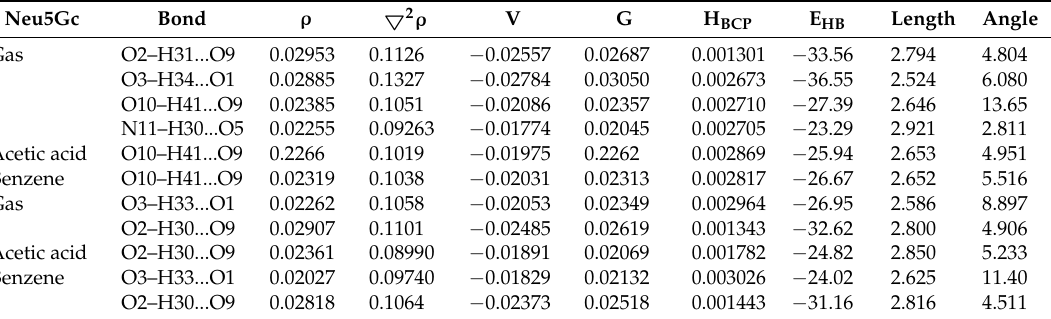
Table 1. Topological parameters at intramolecular bond critical points of Neu5Gc and Neu5Ac. ρ : Electron density (a.u.); ∇ 2 ρ : Laplacian of electron density (a.u.); G: Lagrangian kinetic